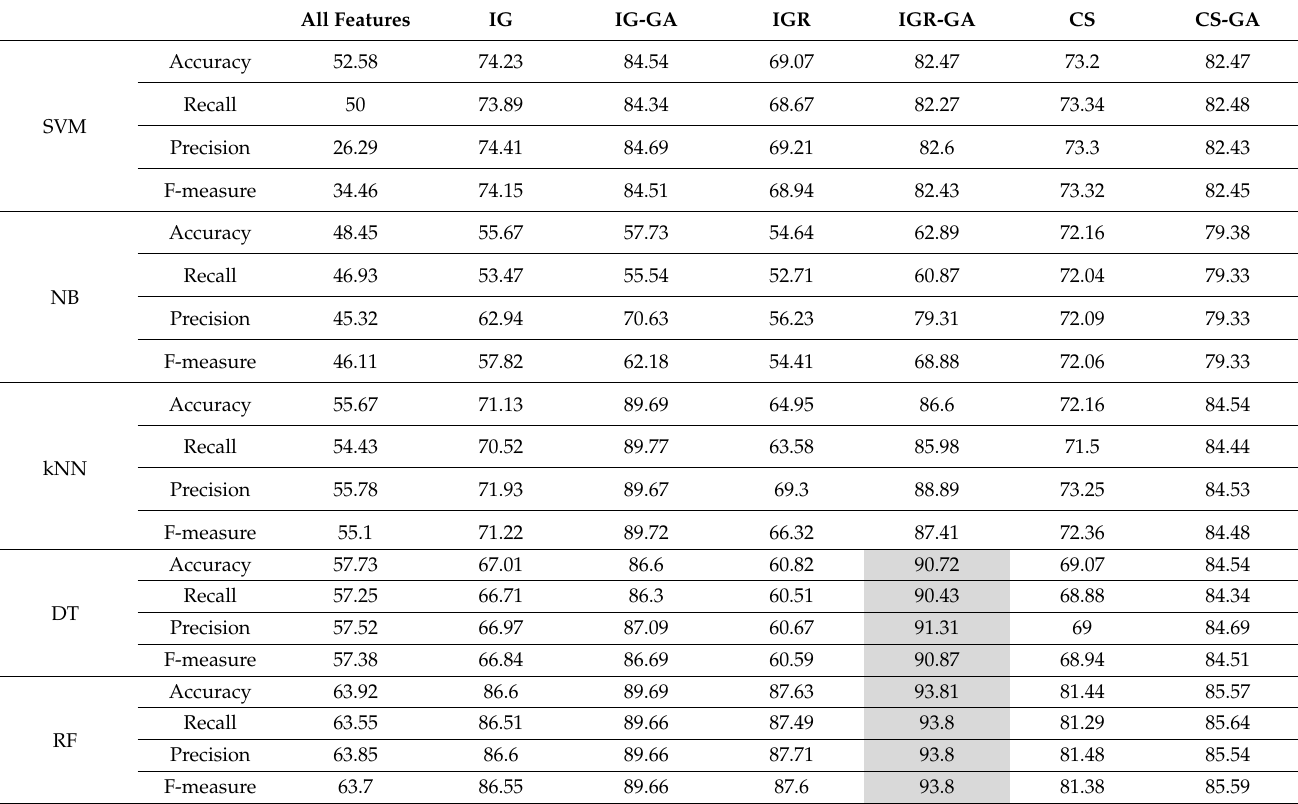
Table 4. The performance comparison of classifiers using all features, the features selected by filters methods, and the features selected by the proposed hybrid filter-GA methods on the Breast